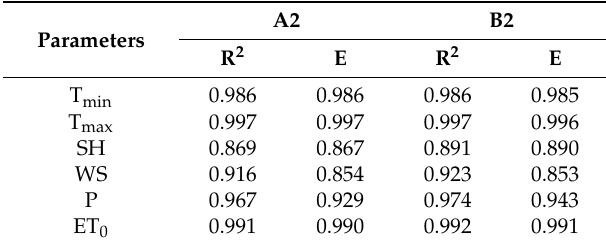
Table 1. R 2 and E of the average monthly value of the downscaled parameters.